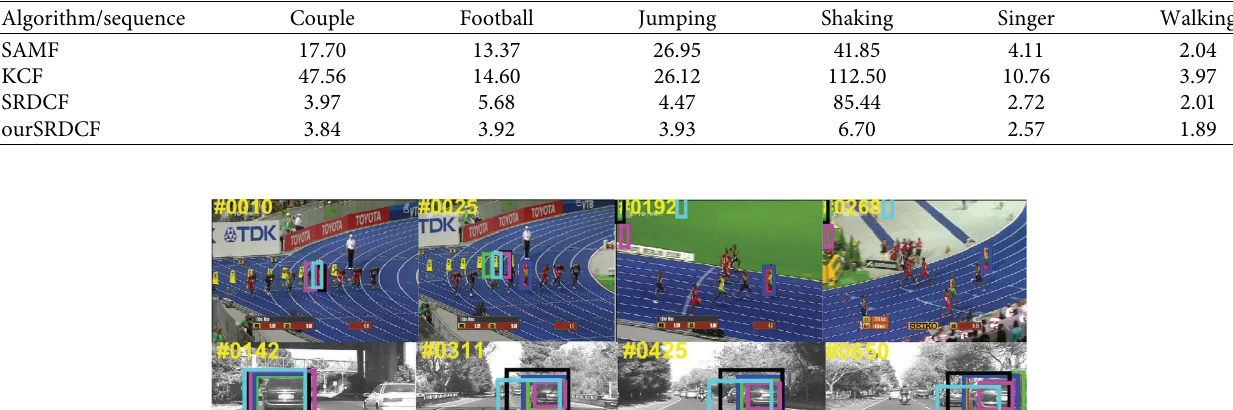
Figure 7: Comparison of center position errors of several tracking algorithms on 6 video sequences. Table 3: Te center position error of the tracking algorithm on 6 video sequences.